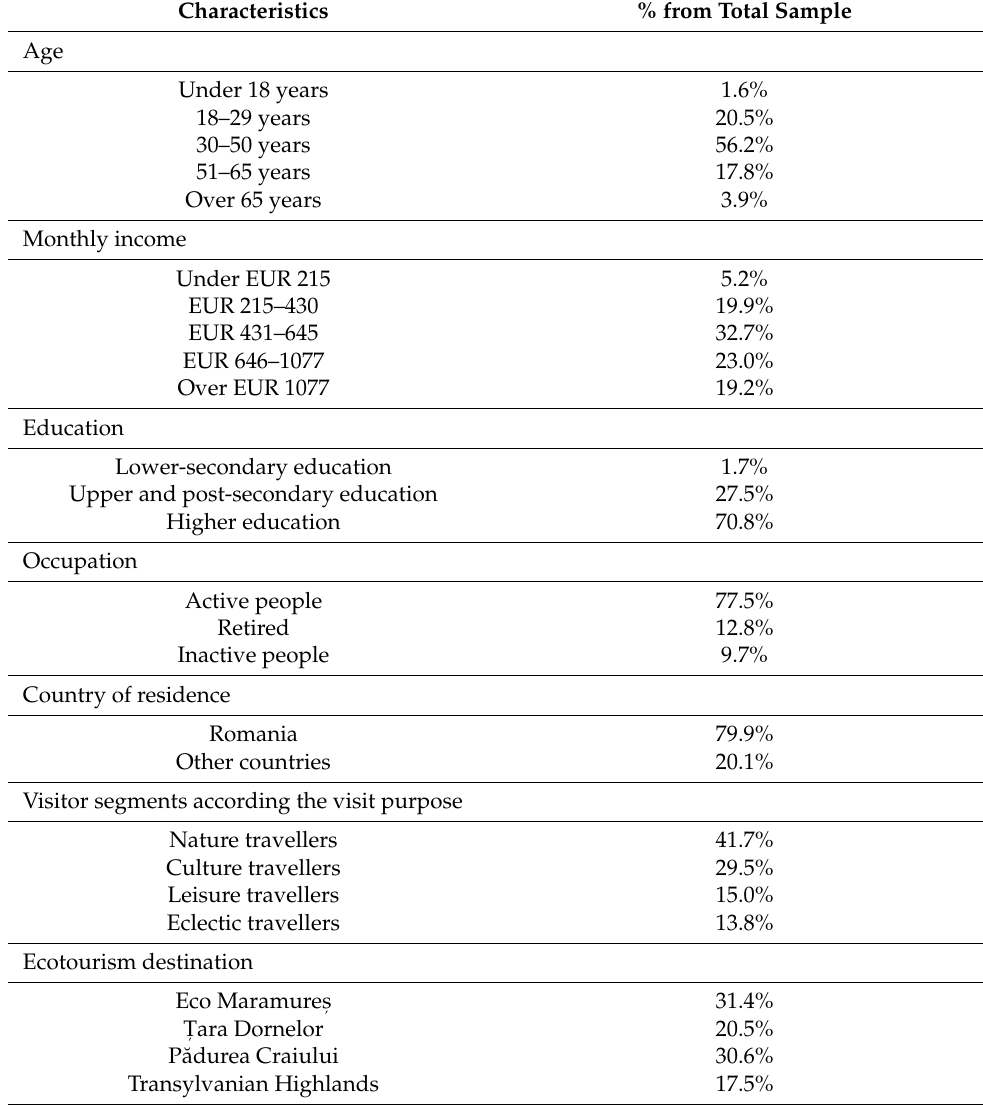
Table 2. The sample structure on demographic and travel